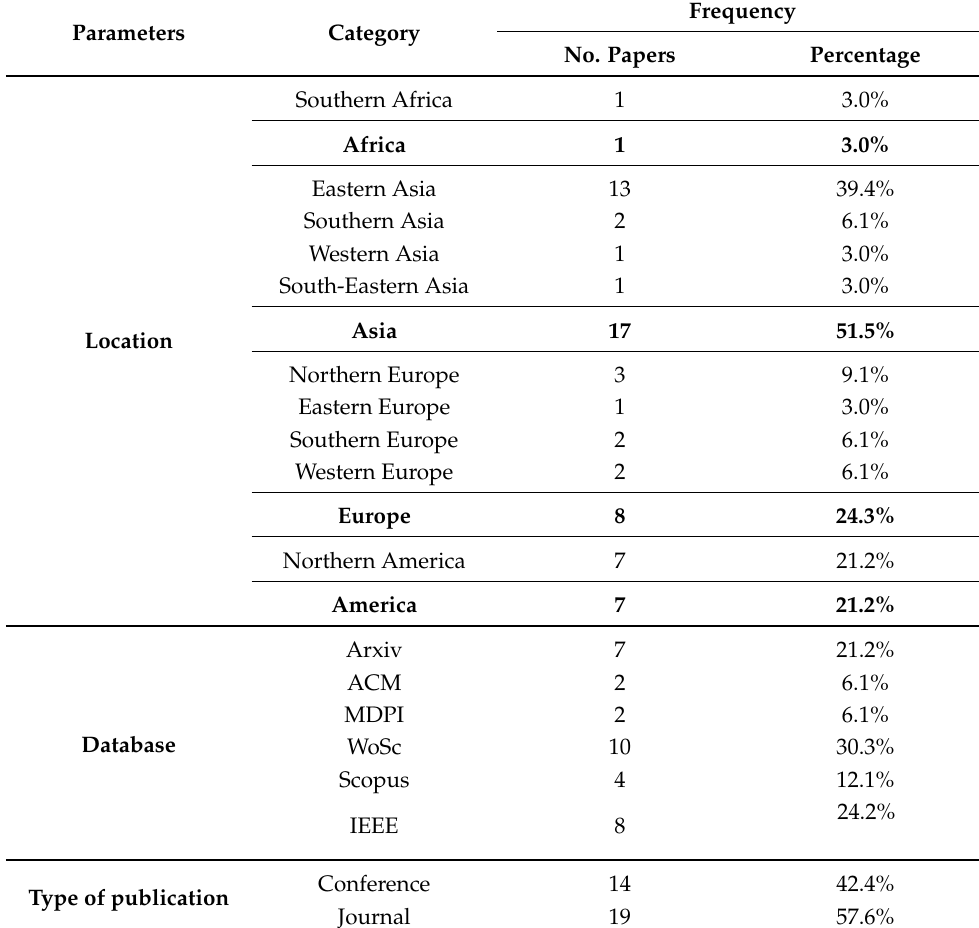
Table 7. Number and frequency of research database, conference or journal and by geographical distribution of